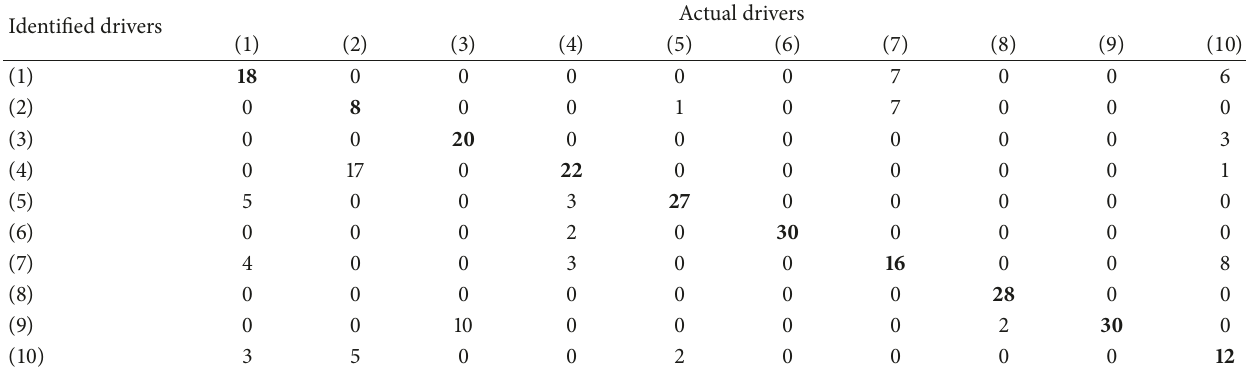
Table 4: Example of how the proposed algorithm identifies each driver.